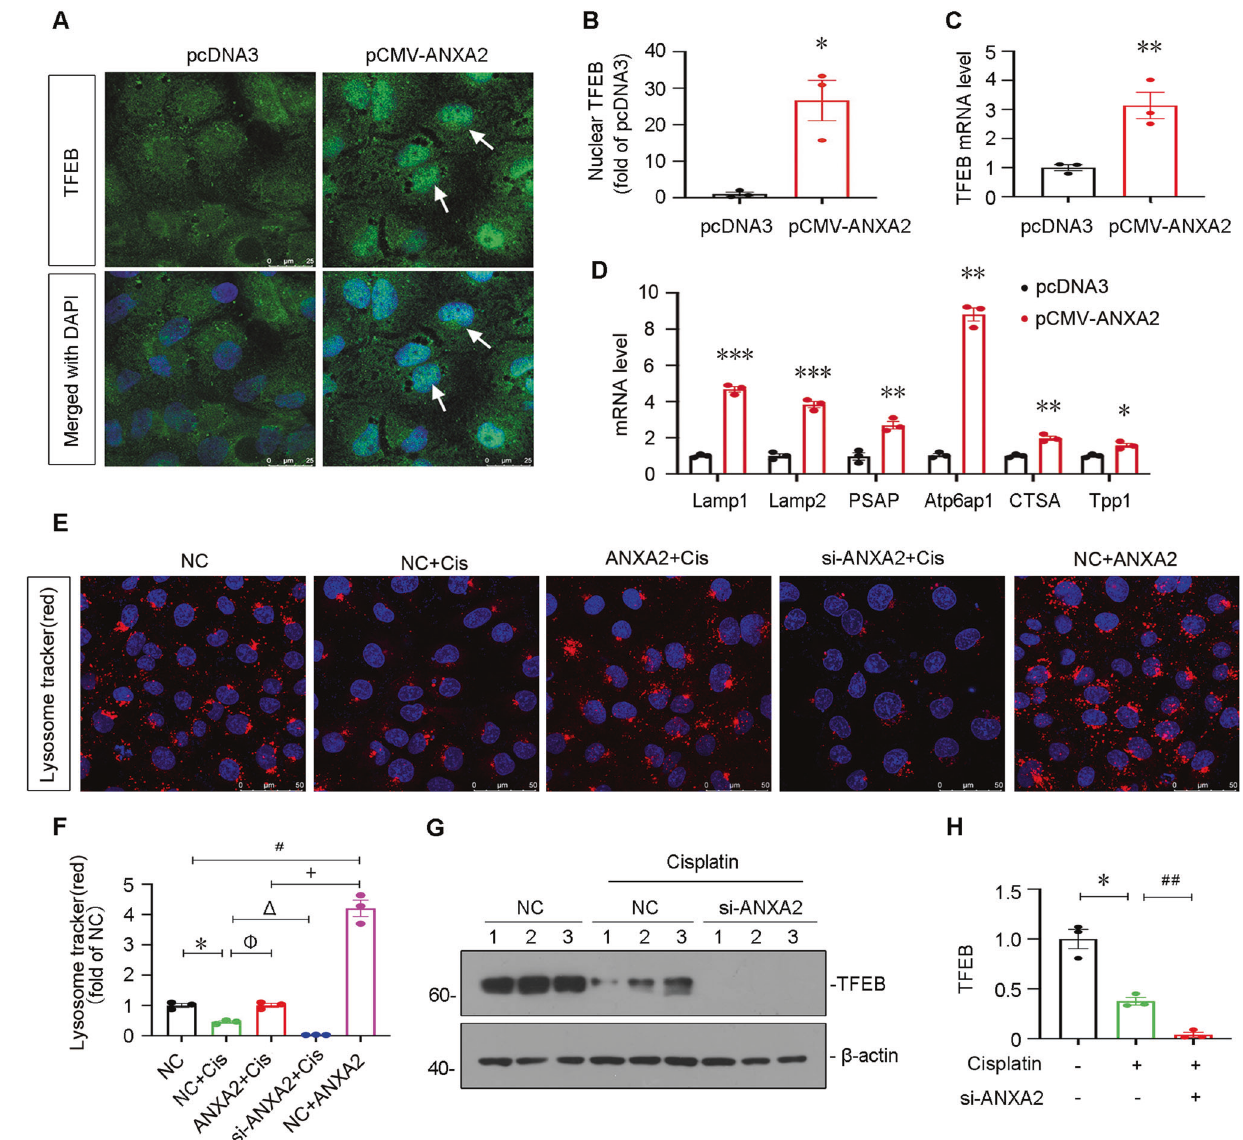
Fig. 8 ANXA2 promotes lysosomal functions through β -catenin/TCF4 signaling. A Representative photographs show the immuno fl uor- escence staining of TFEB ( B ) and its quanti fi cation. White arrows indicate nuclear staining of TFEB. Scale bar, 25 μ m. * P < 0.05 versus pcDNA3 ( n = 3). C qPCR shows the mRNA levels of TFEB. ** P < 0.001 versus pcDNA3 ( n = 3). D qPCR results show the mRNA levels of lysosome-related genes. HK-2 cells were transfected with ANXA2 expression plasmid for 24 h. * P < 0.05, ** P < 0.01, *** P < 0.001 versus pcDNA3 ( n = 3). E , F Representative photographs and quanti fi cation show lysosome staining in different groups. Scale bar, 50 μ m. HK-2 cells were pretreated with recombinant ANXA2 protein (2 μ g/mL) or transfected with siRNA to ANXA2 or negative control (NC) for 24 h, and then treated with cisplatin (25 μ g/mL) or medium alone for another 24 h. * P < 0.05, cisplatin ( n = 3) versus NC alone ( n = 3); # P < 0.05, ANXA2 ( n = 3) versus NC alone ( n = 3); + P < 0.05, cisplatin + ANXA2 ( n = 3) versus ANXA2 + NC ( n = 3); φ P < 0.05, cisplatin + ANXA2 ( n = 3) versus cisplatin + NC ( n = 3); ▵ P < 0.05, cisplatin + si-ANXA2 ( n = 3) versus cisplatin + NC ( n = 3). Representative western blotting ( G ) and quantitative data show the expression of TFEB ( H ) in different groups. * P < 0.05 versus Ctrl ( n = 3); ## P < 0.01 versus Cisplatin alone ( n = 3). HK-2 cells were transfected with si-ANXA2 for 24 h, and then treated with cisplatin (25 μ g/mL) for 24 h. Abbreviations: TFEB transcription factor EB, Lamp1 lysosomal associated membrane protein 1, TPP1 tripeptidyl peptidase the Dual-Luciferase Reporter Assay System (Dual-luciferase Report Assay 6100, USA) or DAB kit (Vector Laboratories SK-4100, USA). For immuno- fl uorescence staining, the fl uorophore-conjugated secondary antibody was System, E1910, Promega, USA). added to the slides, which were counter-stained with DAPI to observe by confocal microscope (Leica Microsystems CMS GmbH, TCS SP8 X, Germany). Pathological and immunohistochemical staining Paraf fi n-embedded kidney sections were stained by periodic acid-Schiff Transmission electron microscopy (TEM) staining according to standard procedure. Immunohistochemical and Kidney tissues or HK-2 cells were collected and fi xed in 1.25% immuno fl uorescence staining were performed in paraf fi n and frozen glutaraldehyde (0.1 mol/L) in phosphate buffer. Ultrathin sections (60 nm) sections. The slides were incubated with primary antibodies and the were prepared by a routine procedure and were examined under an secondary antibodies and visualized using the ABC (VECTA ABC Kit, electron microscope (JEOL JEM-1010, Tokyo, Japan). Peroxidase, PK-6100, USA), AEC (VECTASTAIN Elite ABC Kit, Peroxidase PK-